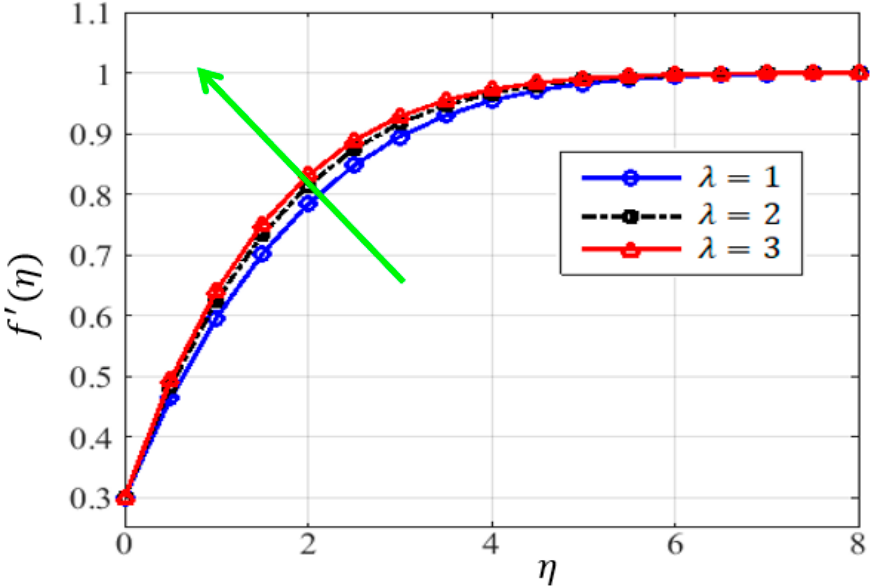
Figure 7. Impact of fl uid fl ow parameter on velocity pro fi le.